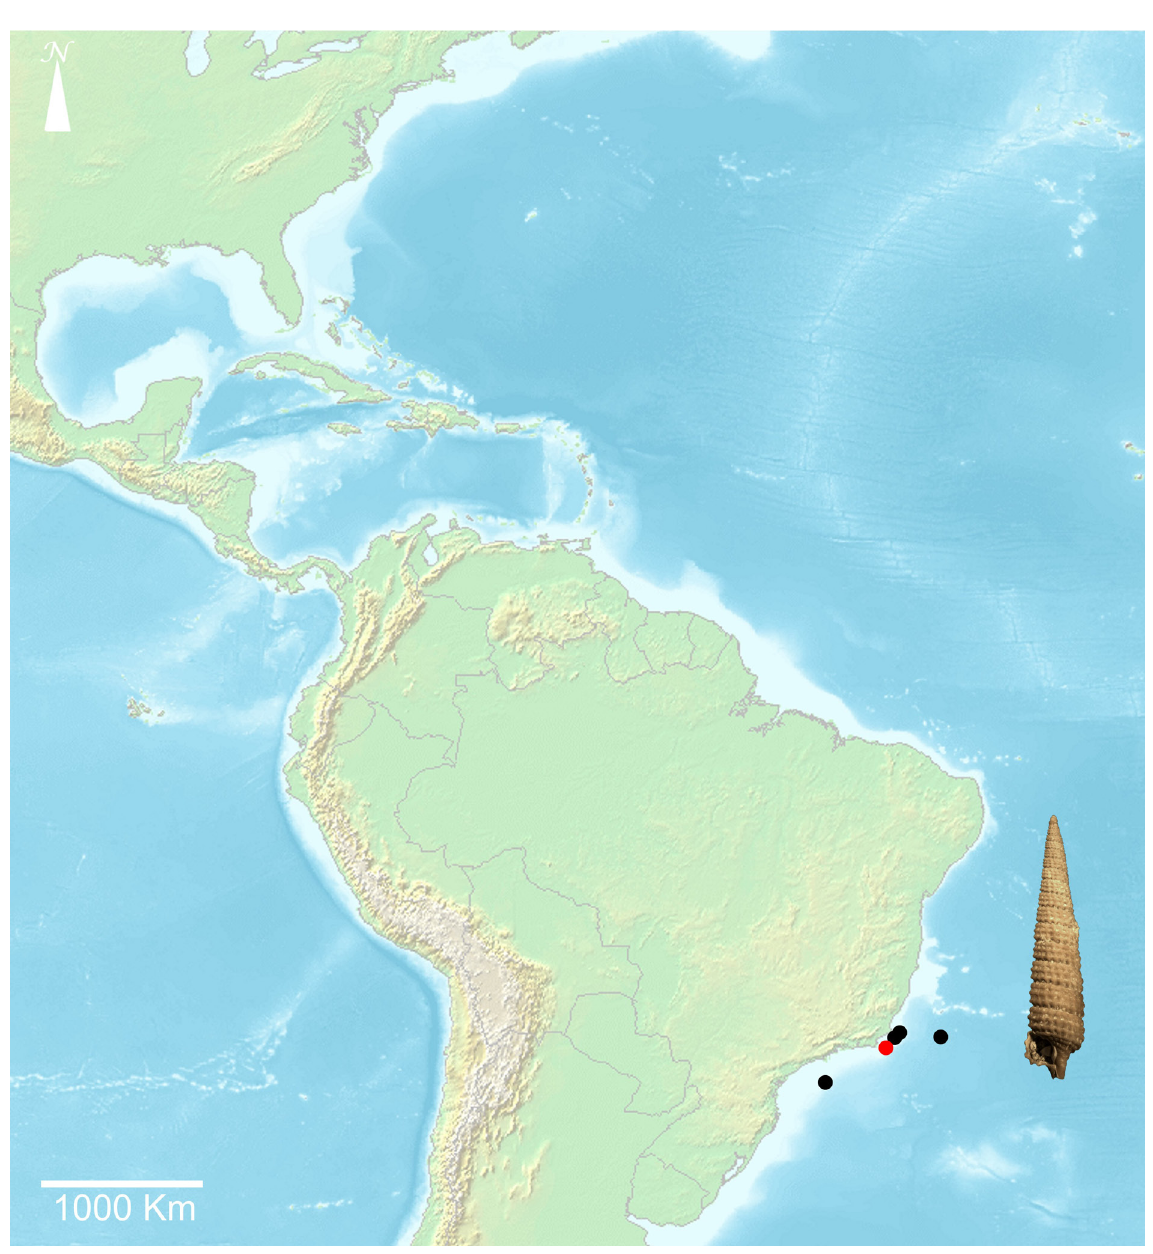
Fig. 37. Distribution map of “ Inella ” euconfio Fernandes & Pimenta, 2019; red circle = type locality.